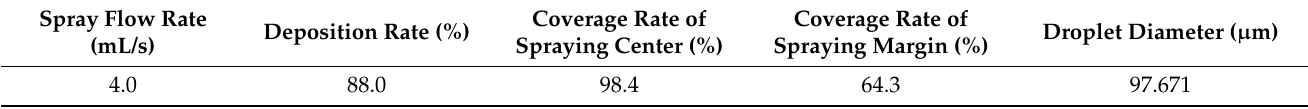
Table 4. The results of the spraying experiment.